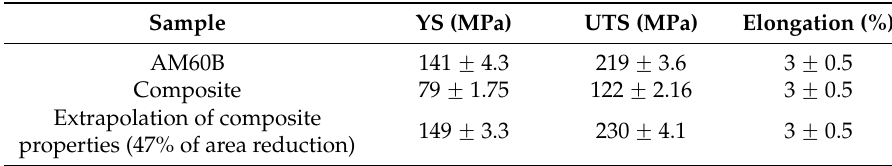
Table 5. Obtained properties of composite